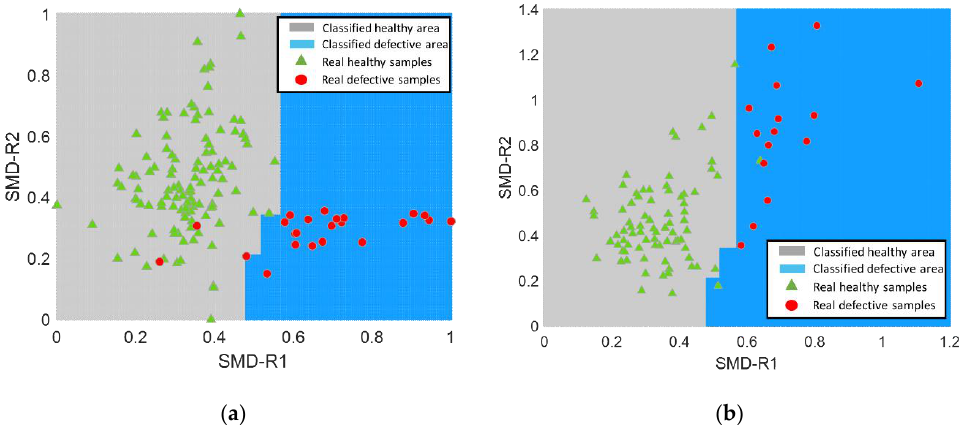
Figure 9. ( a ) 𝐈𝐌𝐂𝐒 𝑹𝑭𝐁𝐏𝐒𝐎 -based classification on the training dataset; ( b ) 𝐈𝐌𝐂𝐒 𝑹𝑭𝐁𝐏𝐒𝐎 -based classification on the testing dataset.